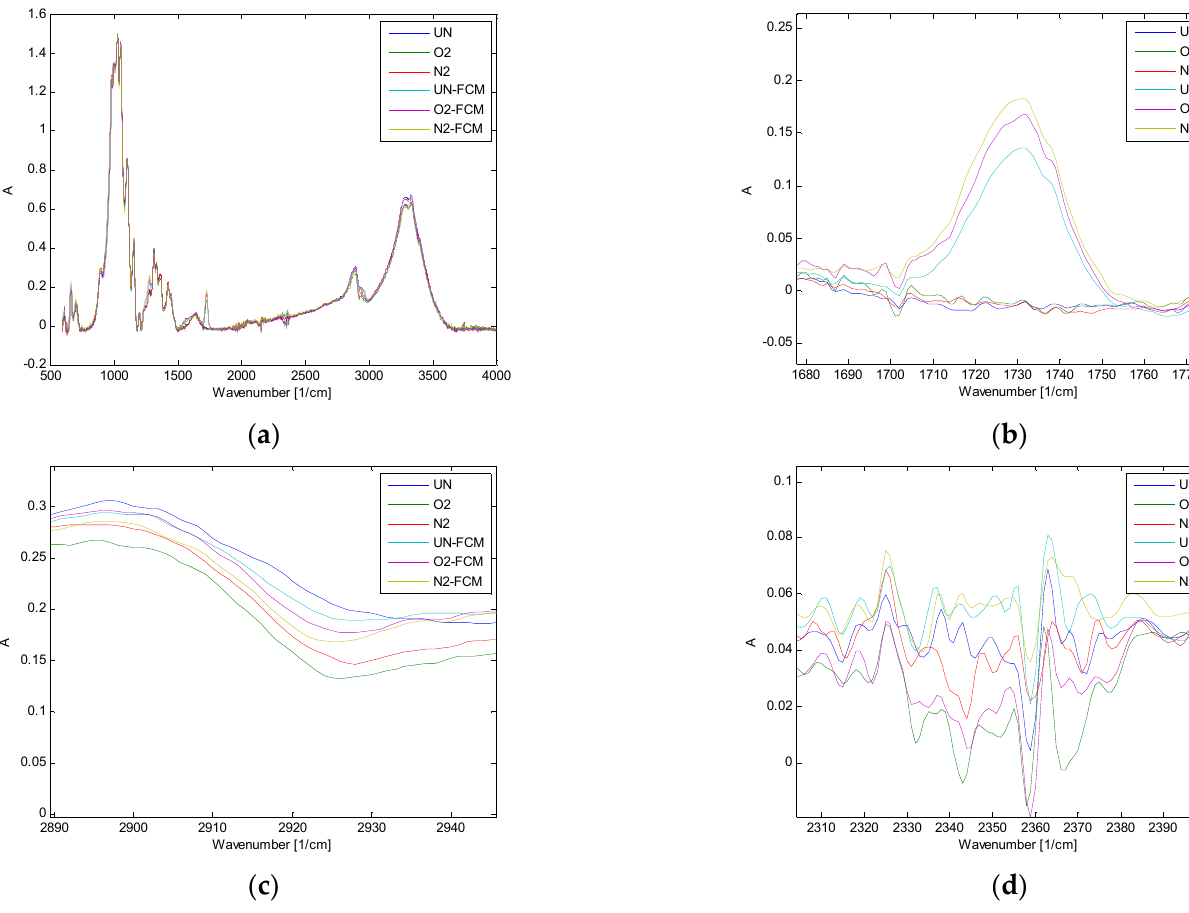
Figure 7. The ( a ) original FTIR spectra and ( b – d ) magnified views of three regions with most pronounced differences among the samples.